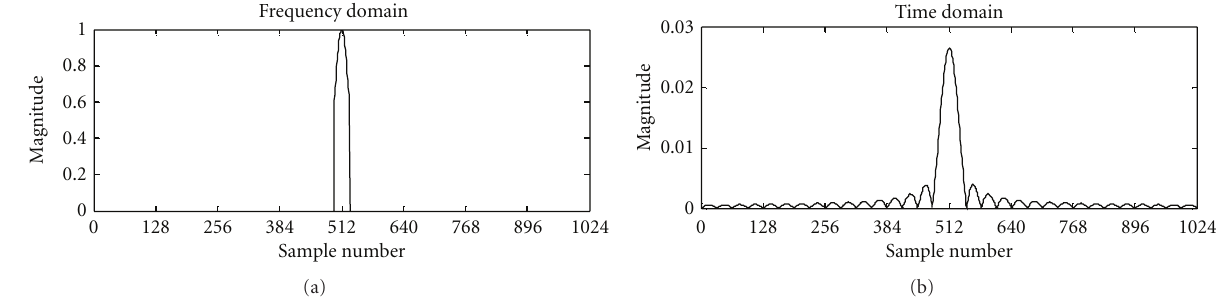
Figure 1: A truncated Gaussian pulse in the frequency domain and its corresponding waveform in the time domain.